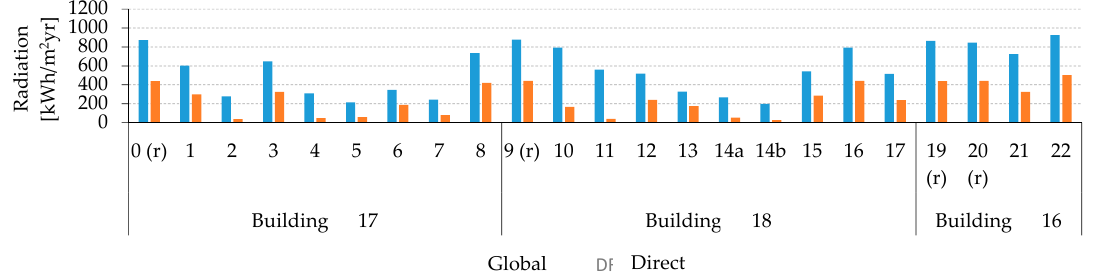
Figure 17. Average irradiation on the roofs (r) and façades in the critical area in the existing situation. The outcomes underline that only for Building 16 is the average global solar irradiation on the façade (surface 22) higher than for the roof surfaces. For the solar energy generation calculation (Figure 18), reduction factors of 52% for the façades and 75% for the roofs are